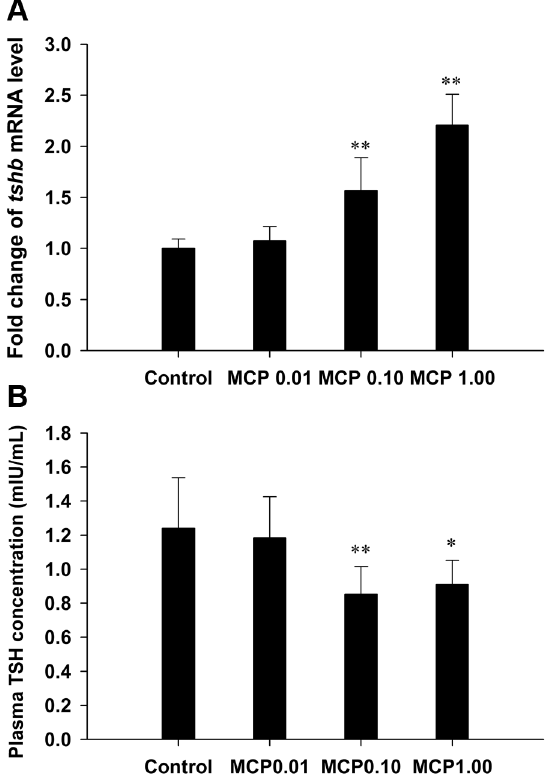
Figure 4. Relative mRNA expression levels of pituitary thyroid- stimulating hormone b subunit ( tsh b ) and quantification of plasma TSH content in female goldfish exposed to 0, 0.01, 0.10, and 1.00 mg/L 40% monocrotophos (MCP) pesticide. (designated C, MCP0.01, MCP0.10, and MCP1.00, respectively). For panel A, fold change (Y axis) represents the expression of the target gene mRNA relative to that of the control group (equals 1 by definition). The data are presented as the means 6 standard deviations (n=9). Asterisks indicate statistically significant differences from the control group (*0.01 , P , 0.05, ** P , 0.01).